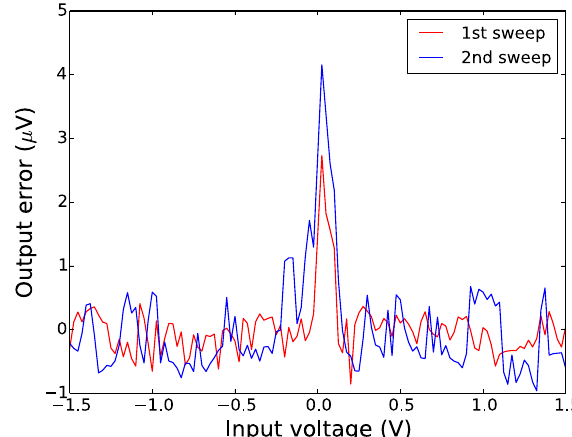
Fig. 4. Resulting error in the linear regressions (parameters found given in Tab. 1) of the two dc sweeps performed on the buffer. The fi rst sweep is in red and the second sweep is in blue. The deviation is well within the ±1 m V band over the entire sweep between±1.5 V with the exception of small section around 0V. Here the output deviation peaks, but it is still less than 5 m V, and is due to the slight mismatch in the manufacturing of the transistors themselves since this feature is not found in the simulation presented on the top of Figure 2.